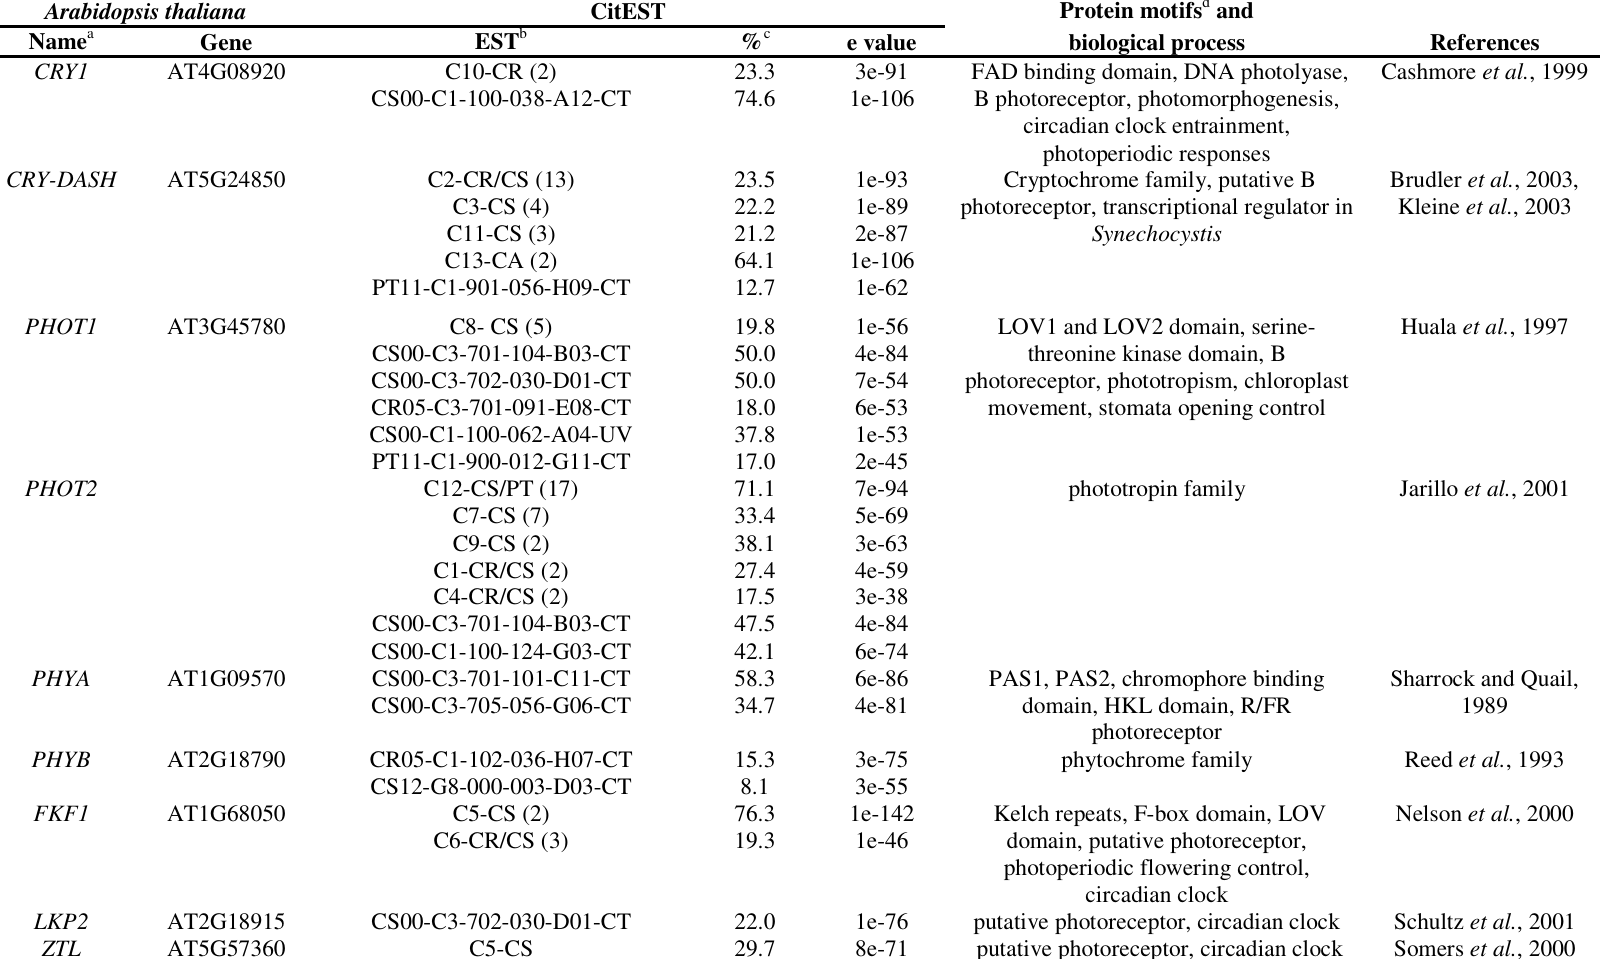
Table S1. Citrus ESTs with homology to photoreceptor and putative photoreceptor gene families of Arabidopsis thaliana . Arabidopsis